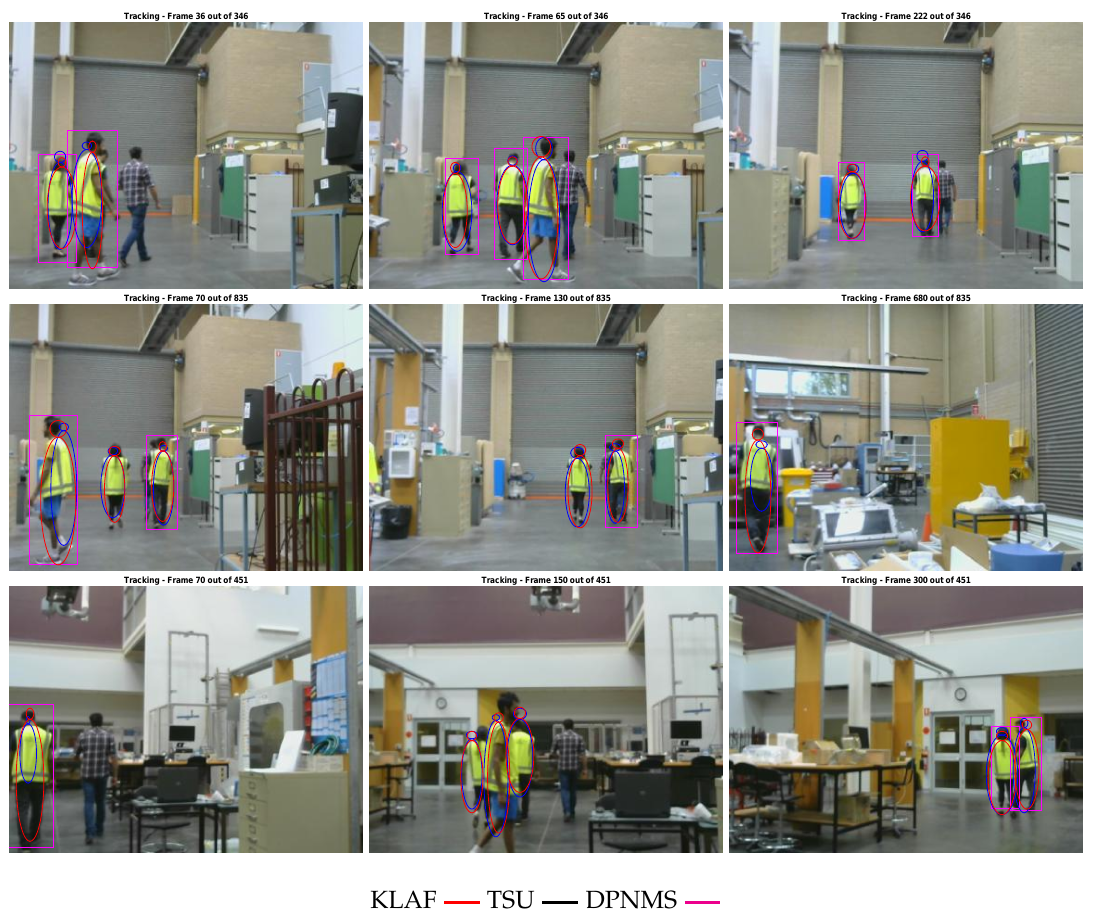
Figure 3. Screen shots of tracking results. Each row is from one sequence. Note: We have omitted the labels of the tracked targets for clarity.